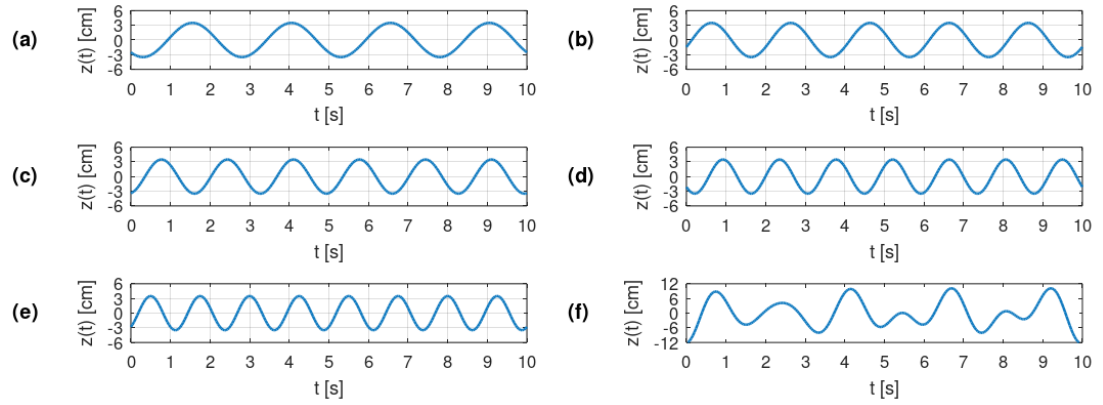
Figure 4. The water wave ( f ) is considered a summation of two-dimensional progressive sinusoidal waves harmonics with amplitudes of 3.5 cm and frequencies of: ( a ) 0.4 Hz, ( b ) 0.5 Hz, ( c ) 0.6 Hz, ( d ) 0.7 Hz, ( e ) 0.8